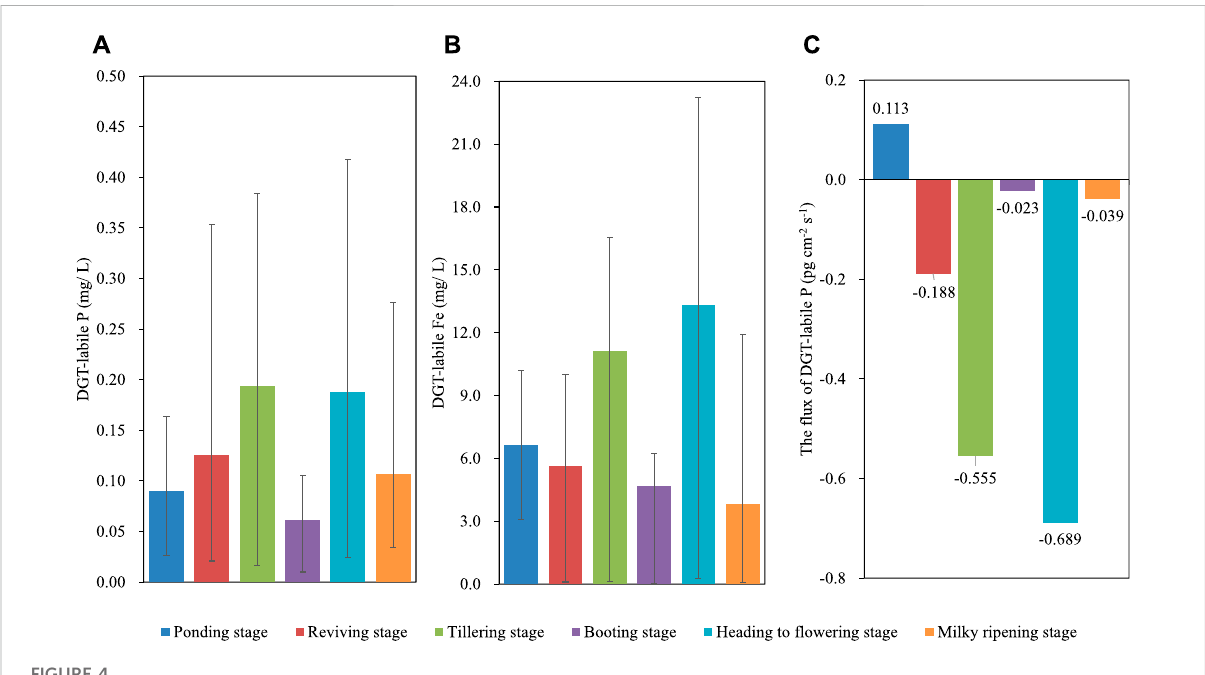
FIGURE 4 Soil vertical DGT-labile P, DGT-labile Fe during the whole growth stage of rice (A) Average concentration of DGT-labile P, (B) Average concentration of DGT-labile Fe and (C) DGT-labile P fl ux across to SWI fl